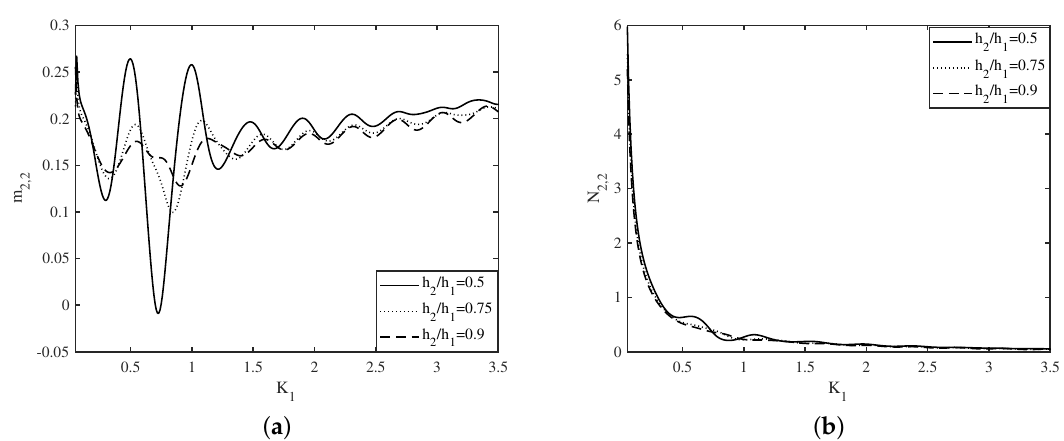
Figure 8. Variation of ( a ) m 2,2 and ( b ) N 2,2 vs K 1 for different h 2 / h 1 .